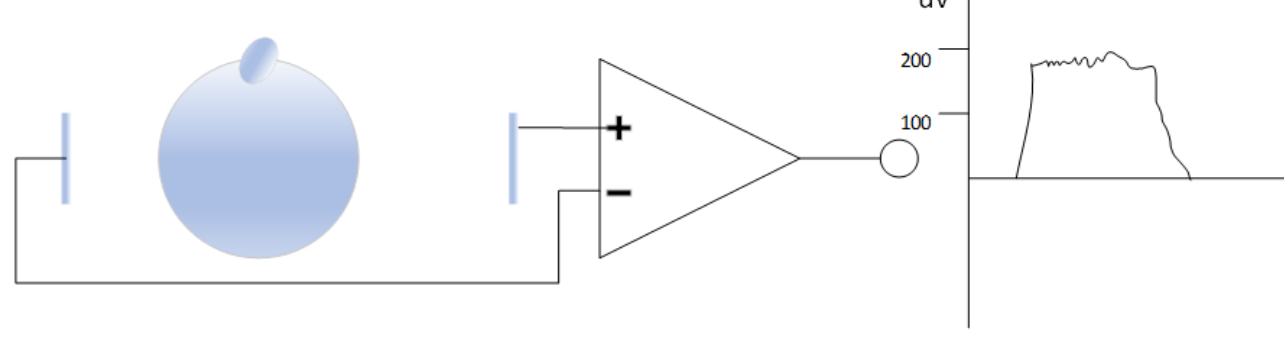
Figure 1. The change of EOG in right eye movement.